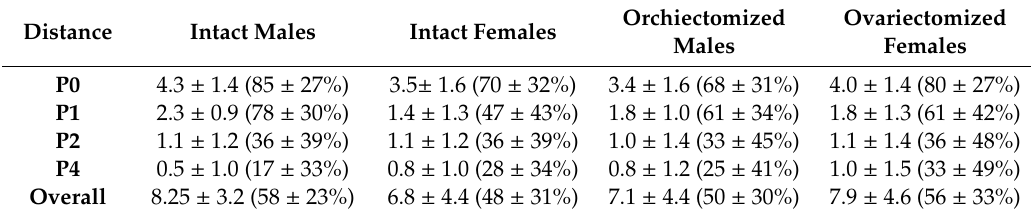
Table 3. Mean ± SD number of S + choices in the Test phase by dogs of di ff erent sex and reproductive status. In brackets: mean ± SD percentage of S + choices on the total number of trials for each distance (i.e., 5 for P0, 3 for P1, P2, and P4).